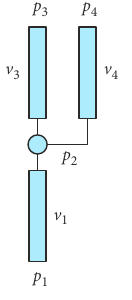
Figure 5. Ventilation model